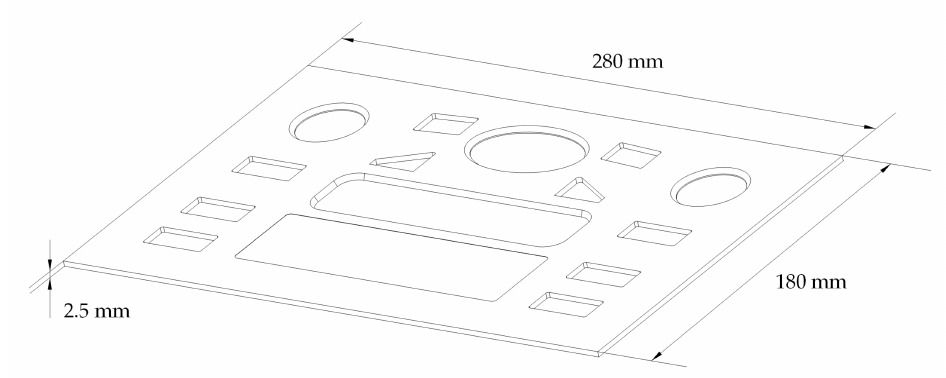
Figure 2. Shape and dimensions of the experimental